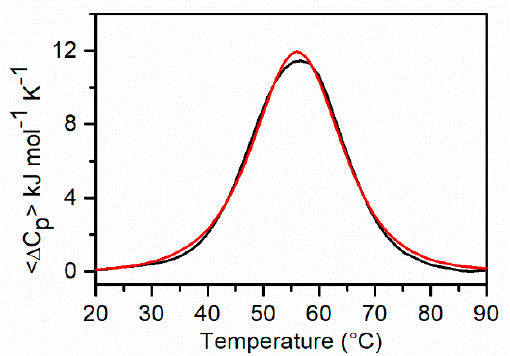
Figure 4. DSC profile of KRAS 32R (black line) and the best fitting curve (red line) obtained by the thermodynamic model described in Section 4.4.1. Table 2. Thermodynamic parameters obtained by the differential scanning calorimetry (DSC) pro- files.